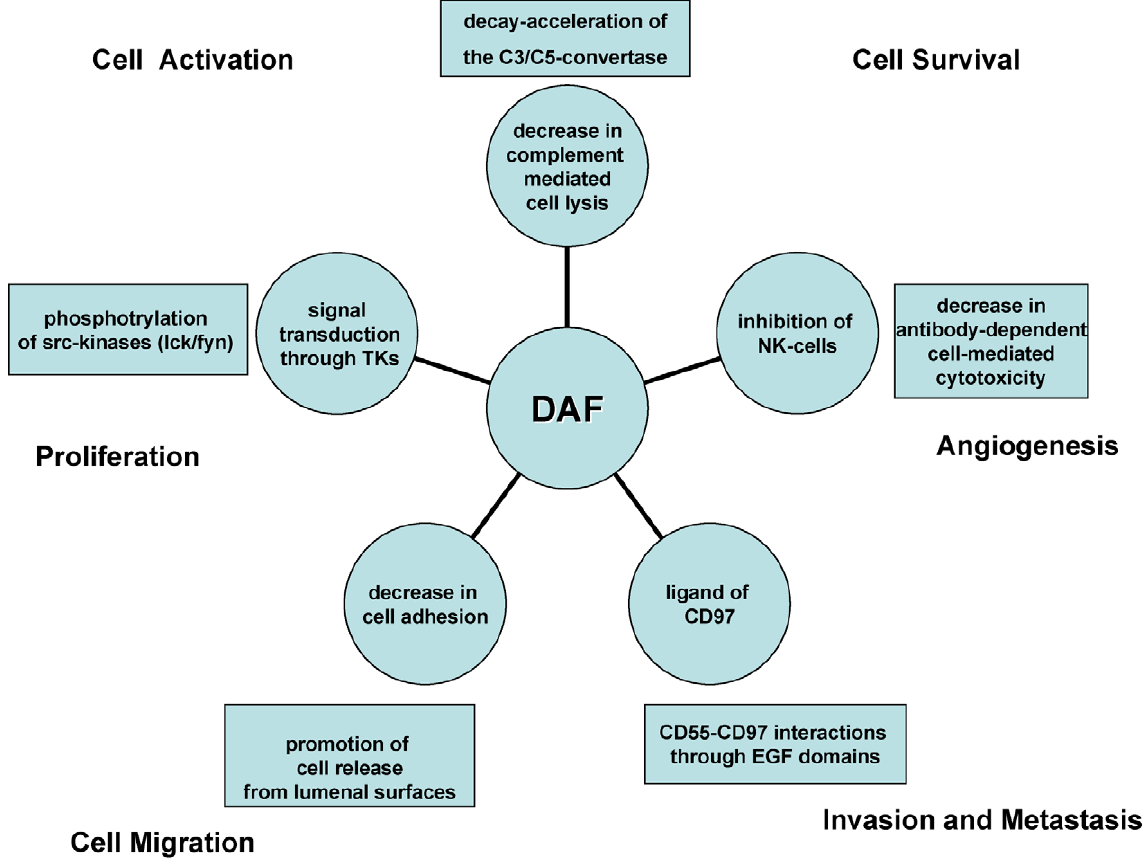
Fig. 3. Survey of the actions of decay-accelerating factor (DAF) in human malignancies. TKs = tyrosine kinases, NK-cells = natural killer